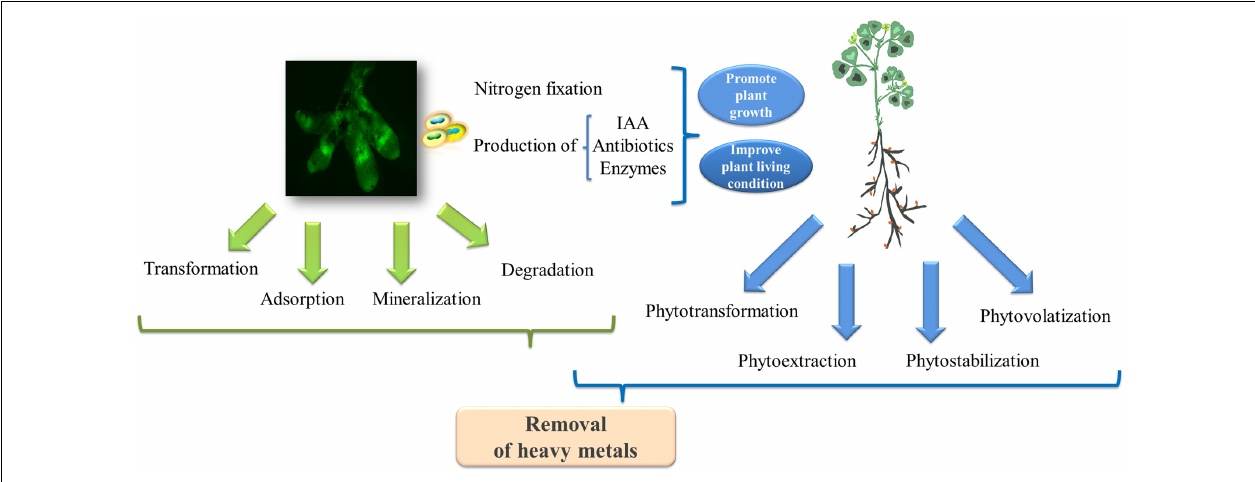
FIGURE 3 |The biodegradation mechanisms involved in the legume-rhizobia symbiosis for the removal of heavy metals. The green fluorescent protein (GFP)-labeled rhizobia in the nodules was photographed by ChenTu at theYantai Institute of Coastal Zone Research, Chinese Academy of Sciences.